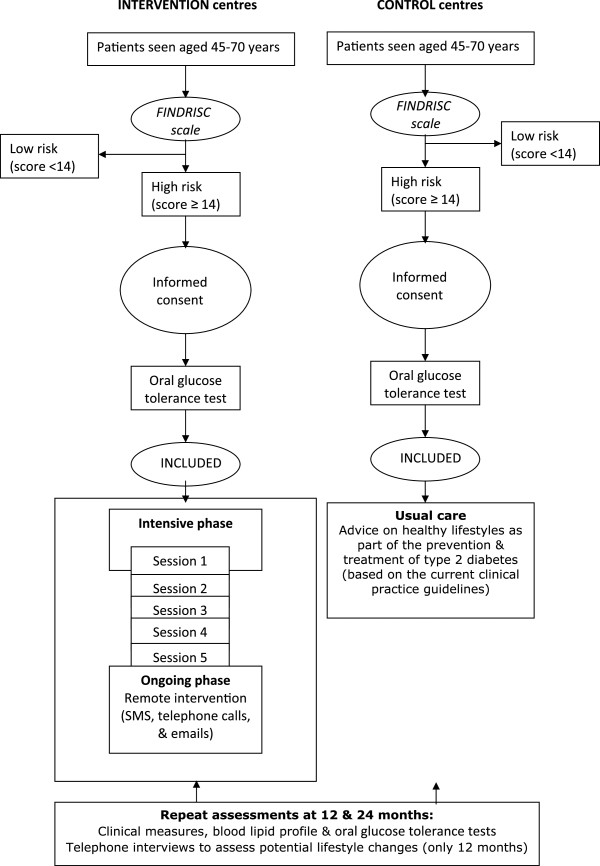
Flow of the study.